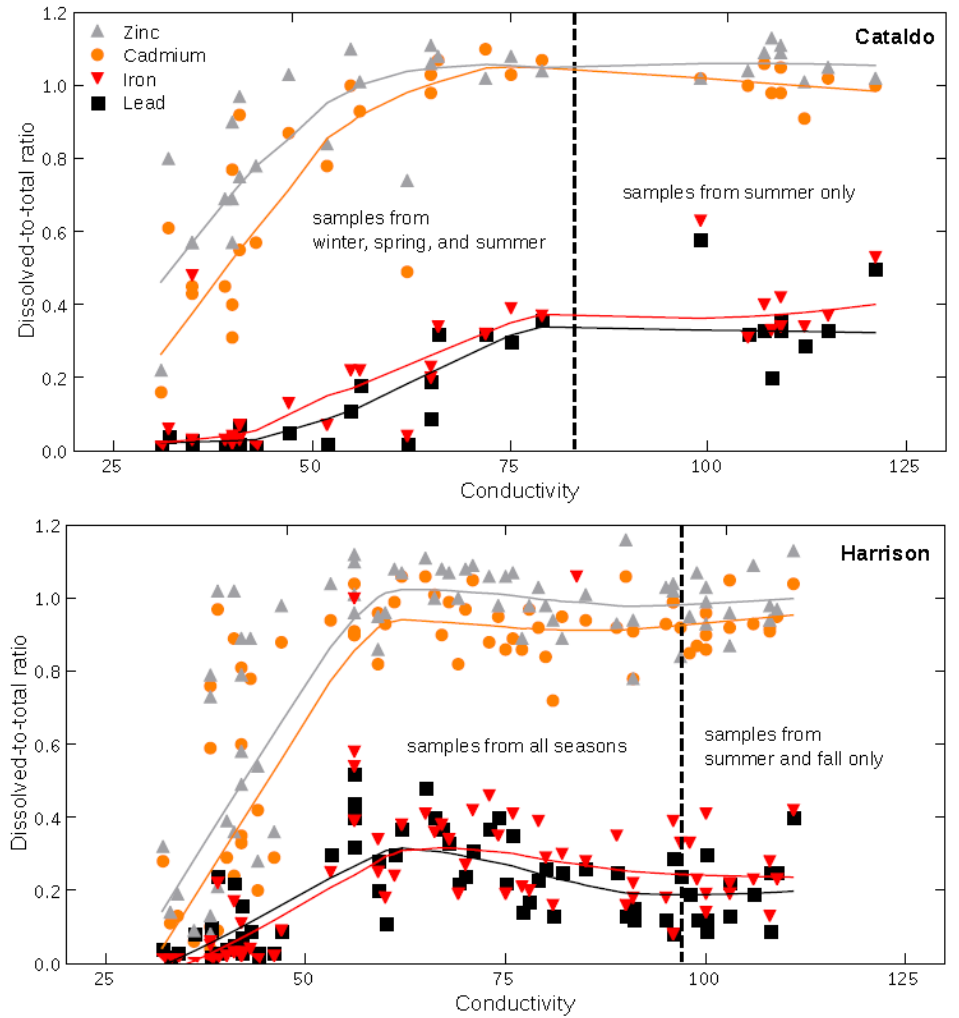
Figure 7. Relation of dissolved-to-total concentration ratios and conductivity in streamflow at the Cataldo and Harrison sites, 2005–2015. Trends are indicated by locally weighted scatterplot smoothing (LOWESS) curves given a 0.5 local neighborhood fraction.